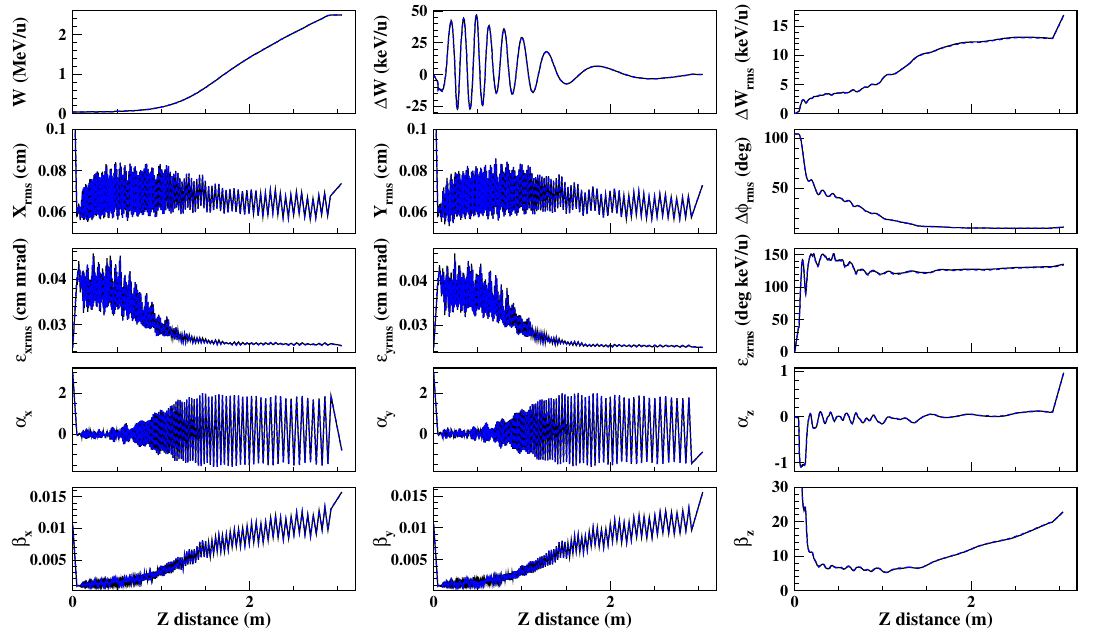
FIG. 9. (Color) Comparisons of simulation results between the serial and parallel versions of TRACK for a 325 MHz RFQ. 10 6 particles of H (cid:1) are accelerated from 50 keV to 2.5 MeV. The plots compare the evolution of most important beam parameters along the RFQ, where solid-black curves are from the serial TRACK and the dashed-blue are obtained from the parallel TRACK .